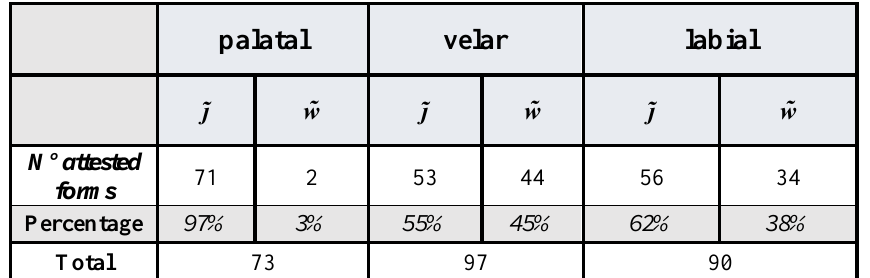
Table 4. Number and percentage of front and back offglides in the ALEPG corpus according to the place of articulation of the consonant occupying the following onset